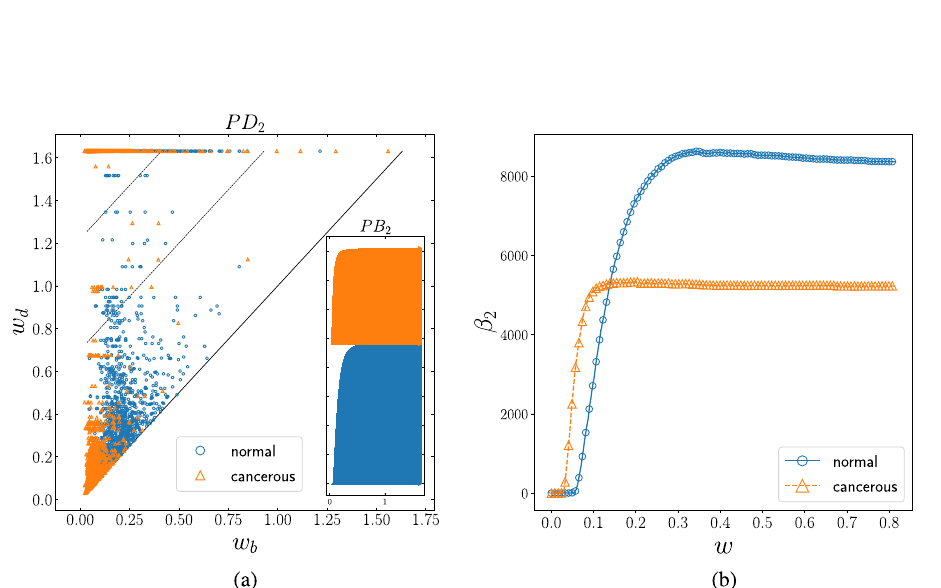
Figure 6. (a) Persistence diagram of 2-homology group ( PD 2 ) for normal (blue circles) and cancerous (orange triangles) interaction network. The normal network contains more persistent voids (persistent pairs between dashed-lines) rather than the cancerous one. Inset: Corresponding persistence barcode ( PB 2 ) for normal (blue bars) and cancerous (orange bars) network. The long bars correspond to the persistent voids, as well, the normal network has more survived void (arrows) rather than the cancerous network. (b) β 2 -curve for normal (blue circle) and cancerous (orange triangle) network. The curves illustrate that the statistics of voids of the networks saturate in various value of threshold, such that the β 2 -curve for the cancerous network saturates earlier (approximately 0.1) than the normal (approximately 0.5) network, while it saturates to the lower value (approximately 5000) than the normal case (approximately